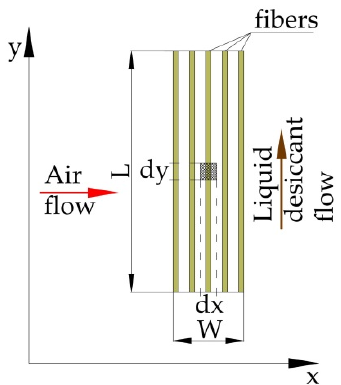
Figure 2. Diagram of cross-flow in a membrane module.